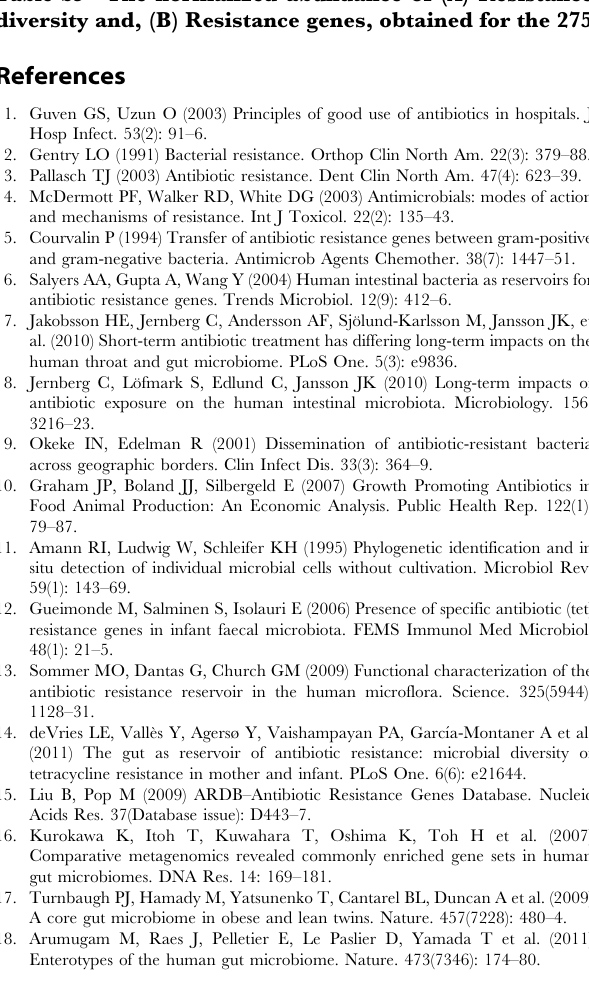
Table S6 List of resistance genes detected specifically in the chinese gut metagenomes. Table S7 Contigs showing hits to more than one antibiotic resistance gene. Table S8 Resistotype affiliations of the 267 adult